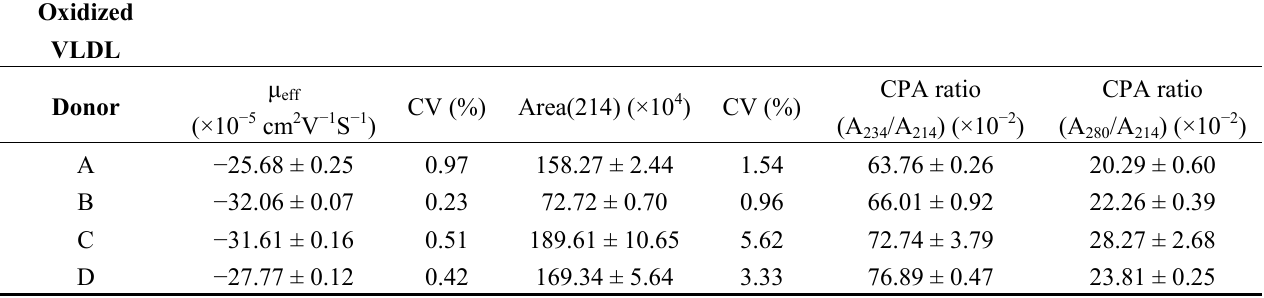
Table 2. The average effective mobility, peak area and peak area ratios of in vitro oxidized VLDL particles analyzed by CZE (data are means ± SD of four replicates).